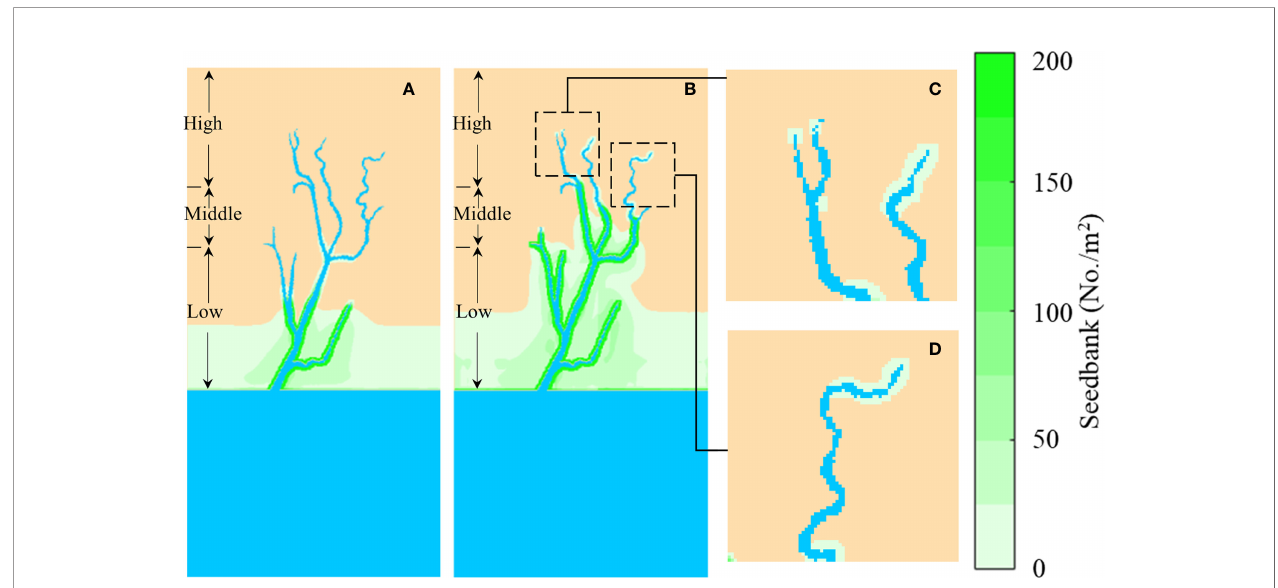
FIGURE 7 | Seedbank density simulation results of H(1) on the 60th Julian day in the second and third year. (A) Second year; (B) Third year; (C) and (D) are seedbank distributions of the third year in high marshes. The blue is tidal channel network and sea; the yellow is bare fl ats. The marsh platform was divided into low, middle and high marshes based on